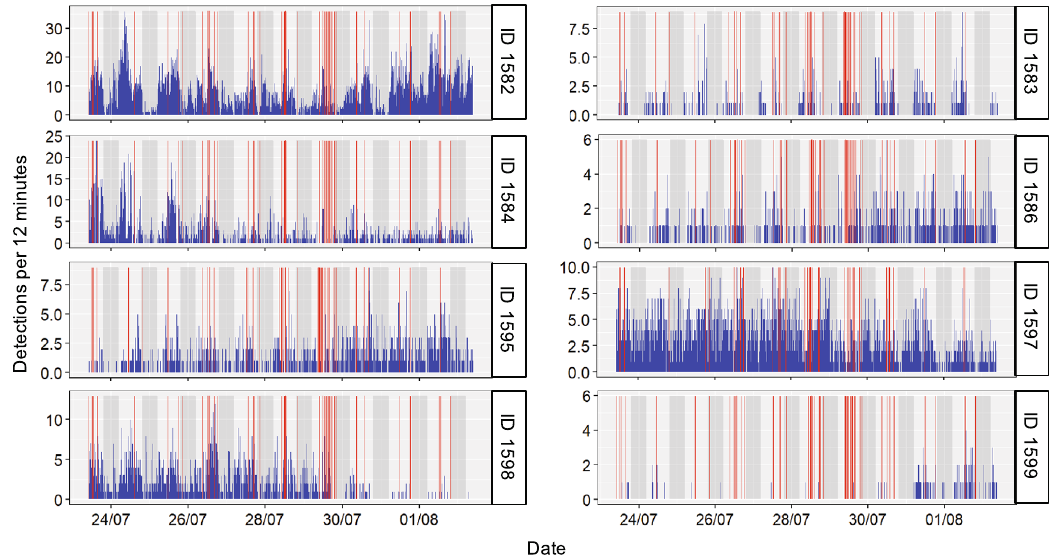
Figure 5. Temporal series of acoustic detections (presence of noise peaks generated by passing motorboats at close range in red and fish detections in blue) during the 10 days of the study for each fish (based on 12-min time steps). Red vertical lines represent the detection of at least a motorboat passing at close range within the 12-min time period according to our Sound Pressure Level analysis. Note the increase of motorboat detections during the weekend (July 29th and 30th). Blue bars represent number of detections for each individual by all the receivers during 12 min. Grey shadowed areas represent night time according to local sunset and sunrise